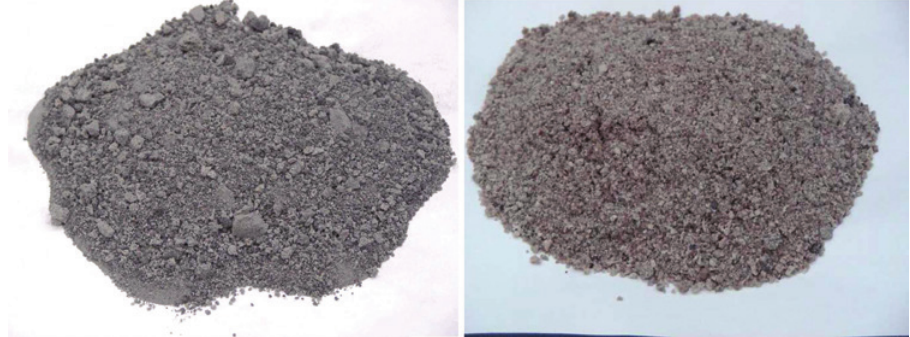
Figure 1: BA (left) and GBFS (right) fine aggregates.